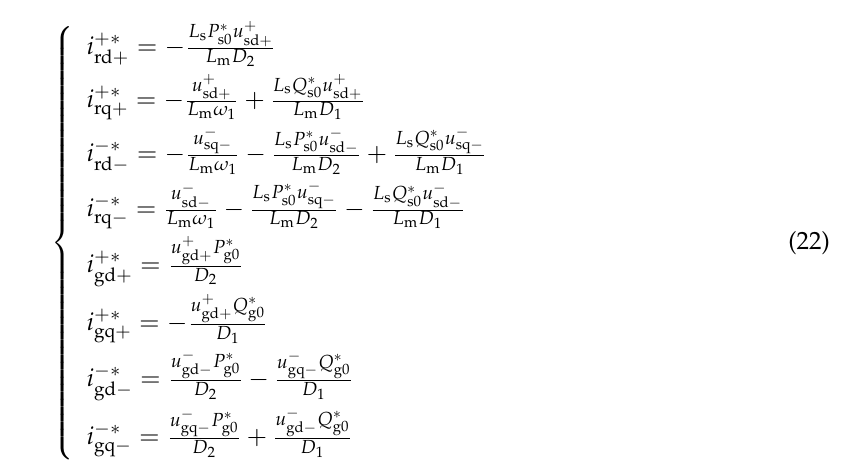
12 of 14 Figure 6. Suppressing the output active power fluctuation: ( a ) Stator active power; ( b ) Grid-side converter active power. 4.2.3. Suppressing Output Reactive Power Fluctuation in a DFIG System Here, the control target under unbalanced grid voltage conditions is to suppress double frequency oscillations of the stator reactive power s Q